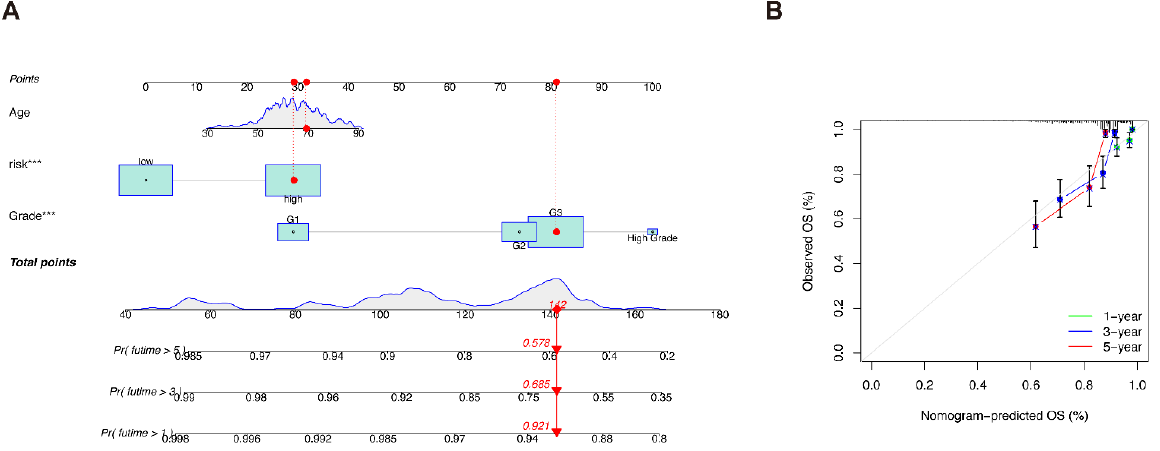
Genes 2022 , 13 , x FOR PEER REVIEW Figure 4. The predictive nomogram. ( A ) The predictive nomogram based on both clinicopathological characteristics and risk classifications. ( B ) Calibration curves of the nomogram. *** p < 0.001. In addition, we also identified the independent prognostic factors for UCEC patients.